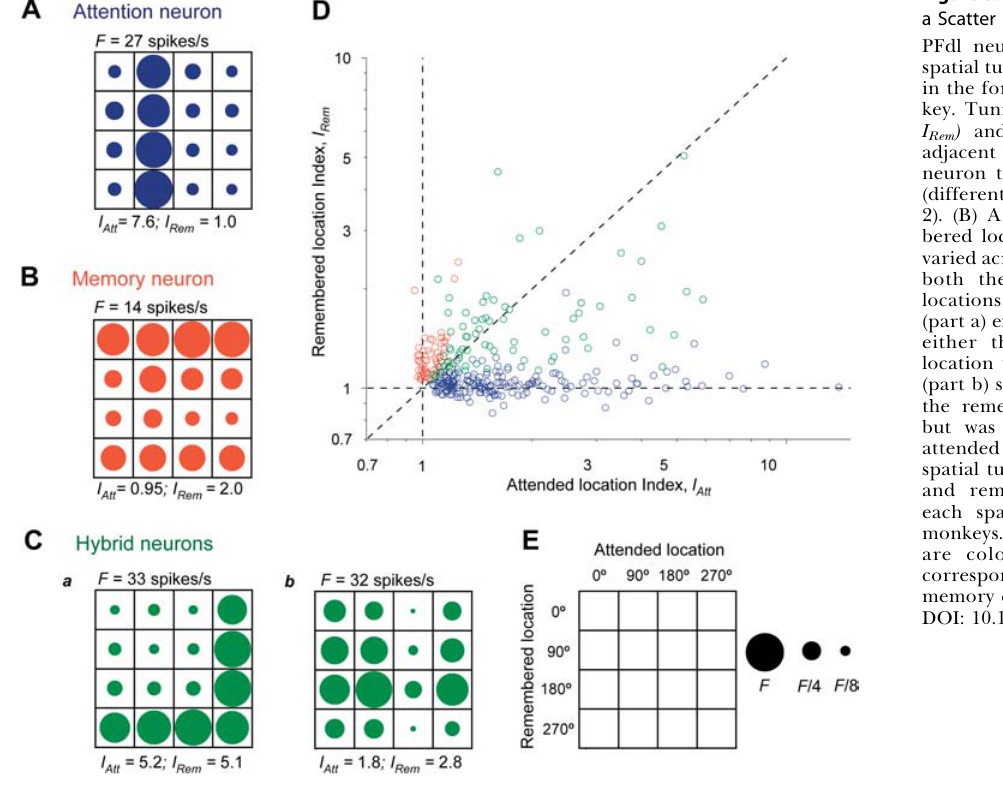
Figure 3. Example Firing Rate Matrices and a Scatter Plot of Tuning Indexes PFdl neurons with different classes of spatial tuning. Firing rate matrices (A–C) in the format of Figure 2C; (E) gives the key. Tuning selectivity indexes (I Att and I Rem ) and firing rate scale (F) appear adjacent to each firing rate matrix. (A) A neuron tuned to the attended location (different from the cell shown in Figure 2). (B) A neuron tuned to the remem- bered location. Its firing rate primarily varied across rows. (C) Two cells tuned to both the attended and remembered locations (hybrid neurons). One neuron (part a) exhibited a high firing rate when either the attended or remembered location was at 270 8 . The other neuron (part b) showed its highest activity when the remembered location was at 180 8 , but was inhibited when that was the attended location. (D) Scatter plot of spatial tuning indexes for attended (I Att ) and remembered (I Rem ) locations for each spatially tuned neuron in both monkeys. The different neuronal classes are color coded as in (A–C): blue corresponds to attention cells, red to memory cells, and green to hybrid cells. DOI: